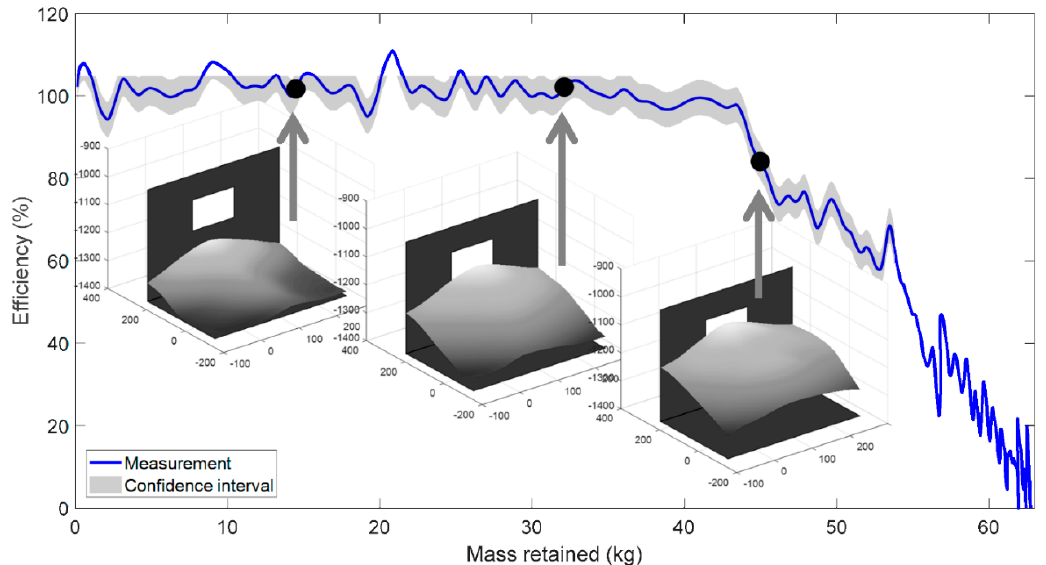
Figure 8. The retained mass and efficiency at which the stereo photos were obtained and the corresponding 3D representation of the sediment beds. The figures of the sediment bed also show the gully pot bottom and back wall including the outlet.